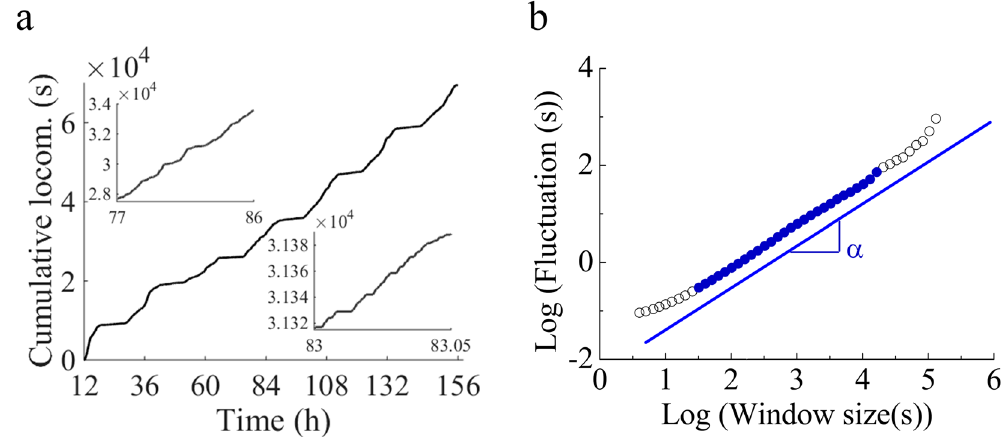
Figure 7. Scale-invariance and long-range correlations in locomotor activity. ( a ) Cumulative locomotion activity of a quail in a home-cage environment. Locomotion was monitored at 0.5 s interval (xi), if the bird was ambulating, xi = 1, and if immobile xi = 0. ( b ) DFA of order 3 (DFA3) of the time series shown in panel a. The double log plot of fluctuation vs . window size is linear (blue line) in the region shown with blue closed circles ( ● ) with slope “ α “, a metric of self-similarity. Of note is that for larger scales there is no evidence of loss of fractal behavior although the estimation of α in this region is unreliable (Supplementary Fig. 11). DFA of order 3 was selected given that it was the lowest order of DFA that eliminated trends in all locomotor time series (Supplementary Fig. 10).